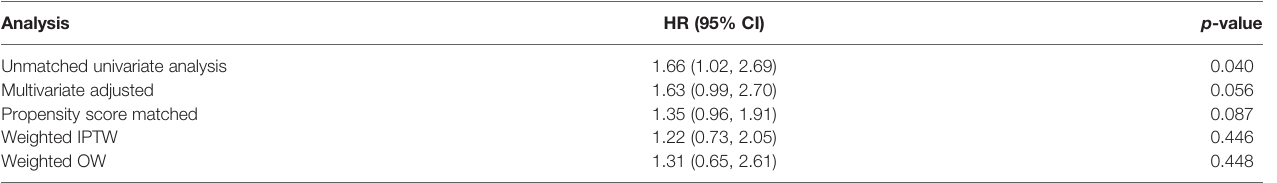
TABLE 2 | Different analysis methods compare the prognostic differences between HAS and SRC patients in overall survival (HAS vs. SRC).